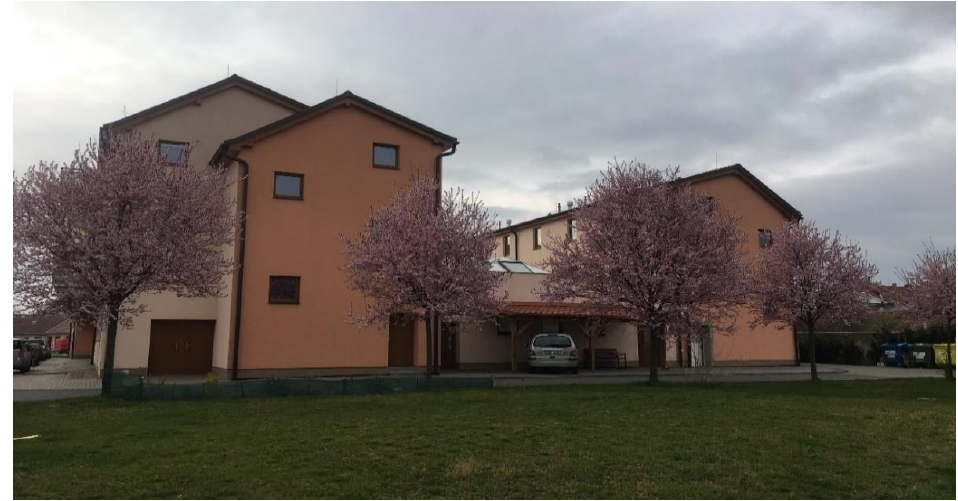
Figure 4. Social care home for elderly people, built on the site of a former socialist agricultural co- operative in Vranovice. Source: K. Charvátová (2021).